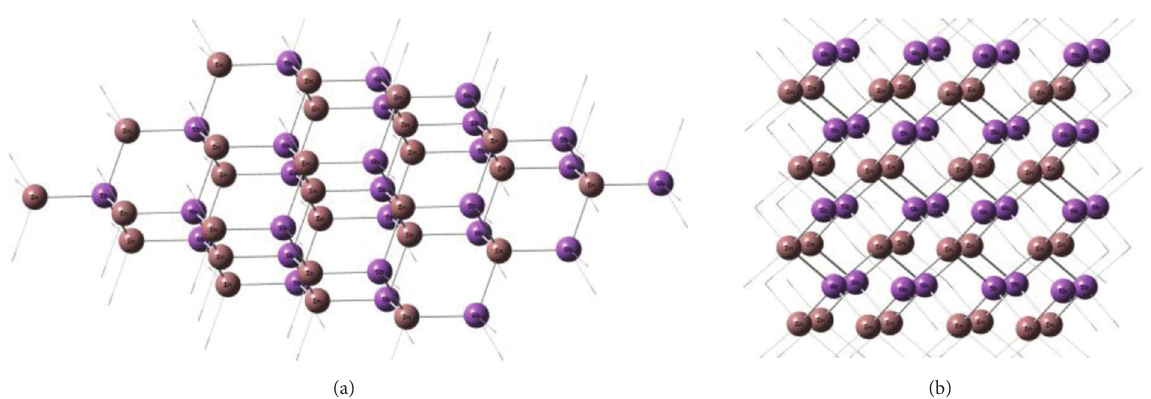
Figure 2: (a) 54-atom (In 27 Sb 27 ) and (b) 64-atom (In 32 Sb 32 ) LUC that represent the core of 470 and 512 combined In and Sb atoms cluster (after adding the periodically repeated cells), respectively. PBE/STO-3G method is used for the LUC